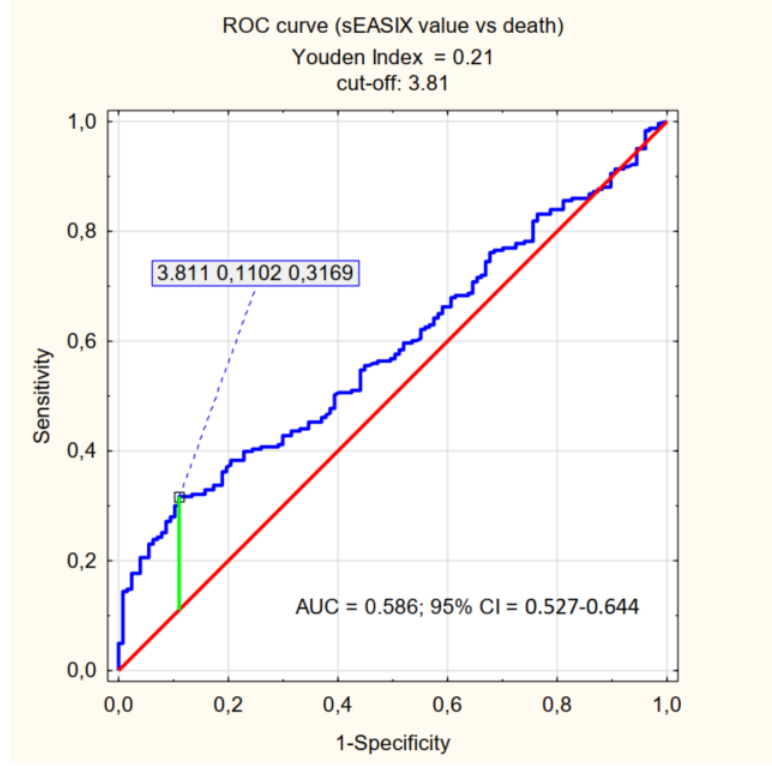
Figure 3. ROC curve (effect of sEASIX value on death) = sEASIX cut-off. In the group of patients with high EASIX, compared to those with low EASIX values, there were more male patients, more cases of circulatory system diseases and chronic re- nal failure, a greater frequency and shorter time of application of IMV, and significant differences in CRP, procalcitonin, ferritin, LDH, platelets, D-dimer, INR, AST and creati- nine values. The high mEASIX and high sEASIX groups were characterised by a lower frequency and shorter time of application of HFNO, more frequent application of IMV and significant differences in CRP, procalcitonin, ferritin, LDH, lymphocytes, platelets, D- dimer, AST, ALT and creatinine values. Furthermore, higher INR values were observed in the high mEASIX group, which were not observed in the high sEASIX group. In turn, the high sEASIX group was also characterised by significant differences in the neutrophils count. In both modified coefficient groups (high mEASIX and high sEASIX), a shorter pe- riod between admission to the hospital and admission to the ICU was observed, while there were no differences with regard to the presence of comorbidities. For all coefficients being assessed, a significantly lower SpO 2 value, shorter period of use of non-rebreather mask 10–15 L/min and a greater frequency of admission to the ICU were observed in the “high” groups. In turn, the patient’s age and haemoglobin concentration were not statis- tically significant in any of the groups, neither was diabetes, obesity and respiratory dis- eases. Males dominated the high EASIX and high mEASIX groups. In the subsequent assessments of the course of hospitalisation, the values of the coef- ficients analysed were determined in the context of forecasting the use of particular meth- ods of oxygen therapy. A significant correlation ( p < 0.001) was only observed for IMV in the context of EASIX values with a cut-off point of 4.1 (Table 4, Figure 4). For the modified coefficients, the correlation was statistically insignificant.